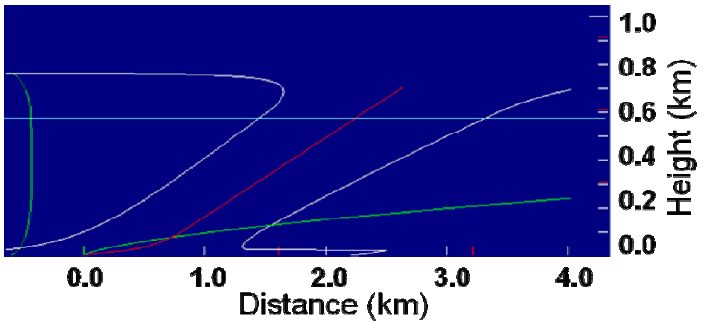
Figure 13. Plume boundaries (white lines) for the highly-tilted plume simulated by Daysmoke for the 23 January 2009 prescribed burn. Other lines are: plume axis (red), the Briggs solution (green), the mixing height (light blue), and the plume vertical velocity (alternating dark green/light